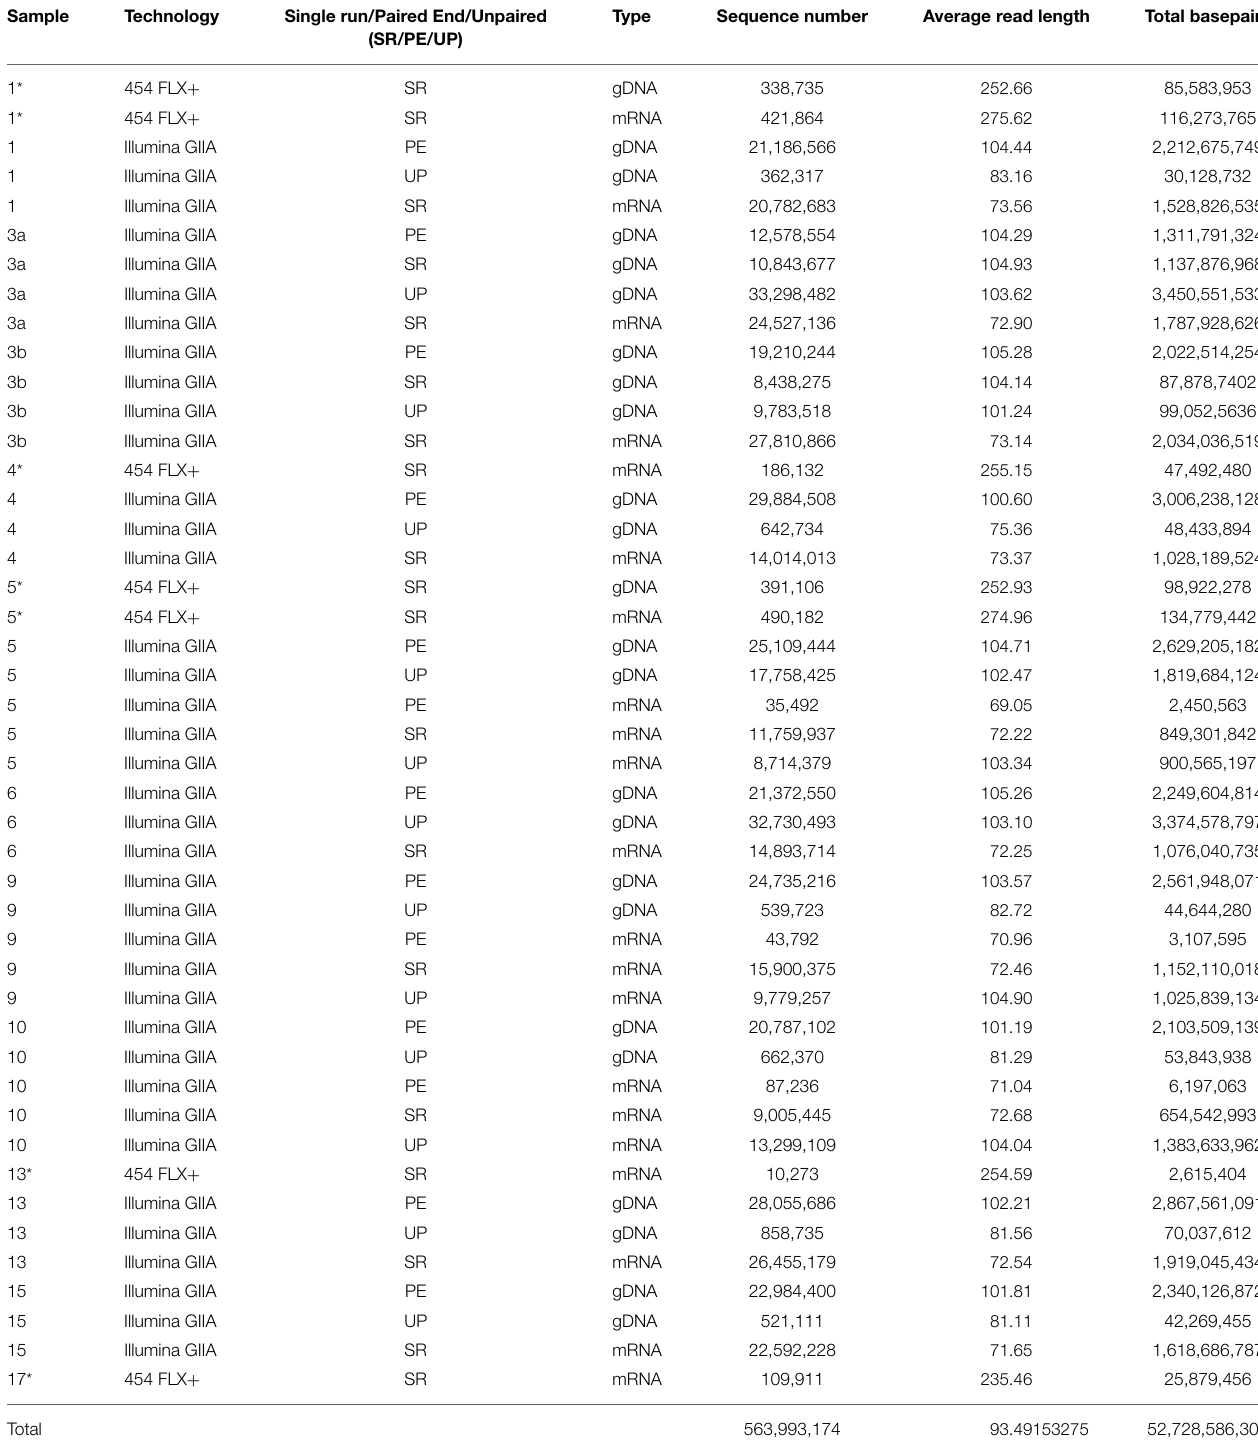
TABLE 3 | Sequence statistics of the quality trimmed metagenome and metatranscriptome data used in this study.